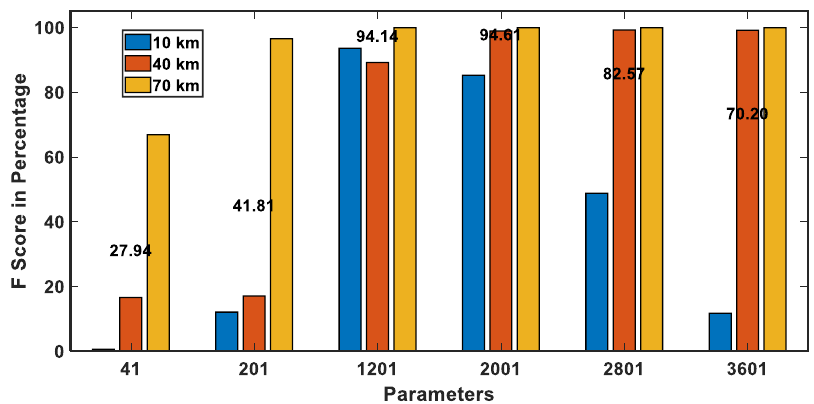
Figure 11. F-Score of 5% leak detection using various parameters at different locations.